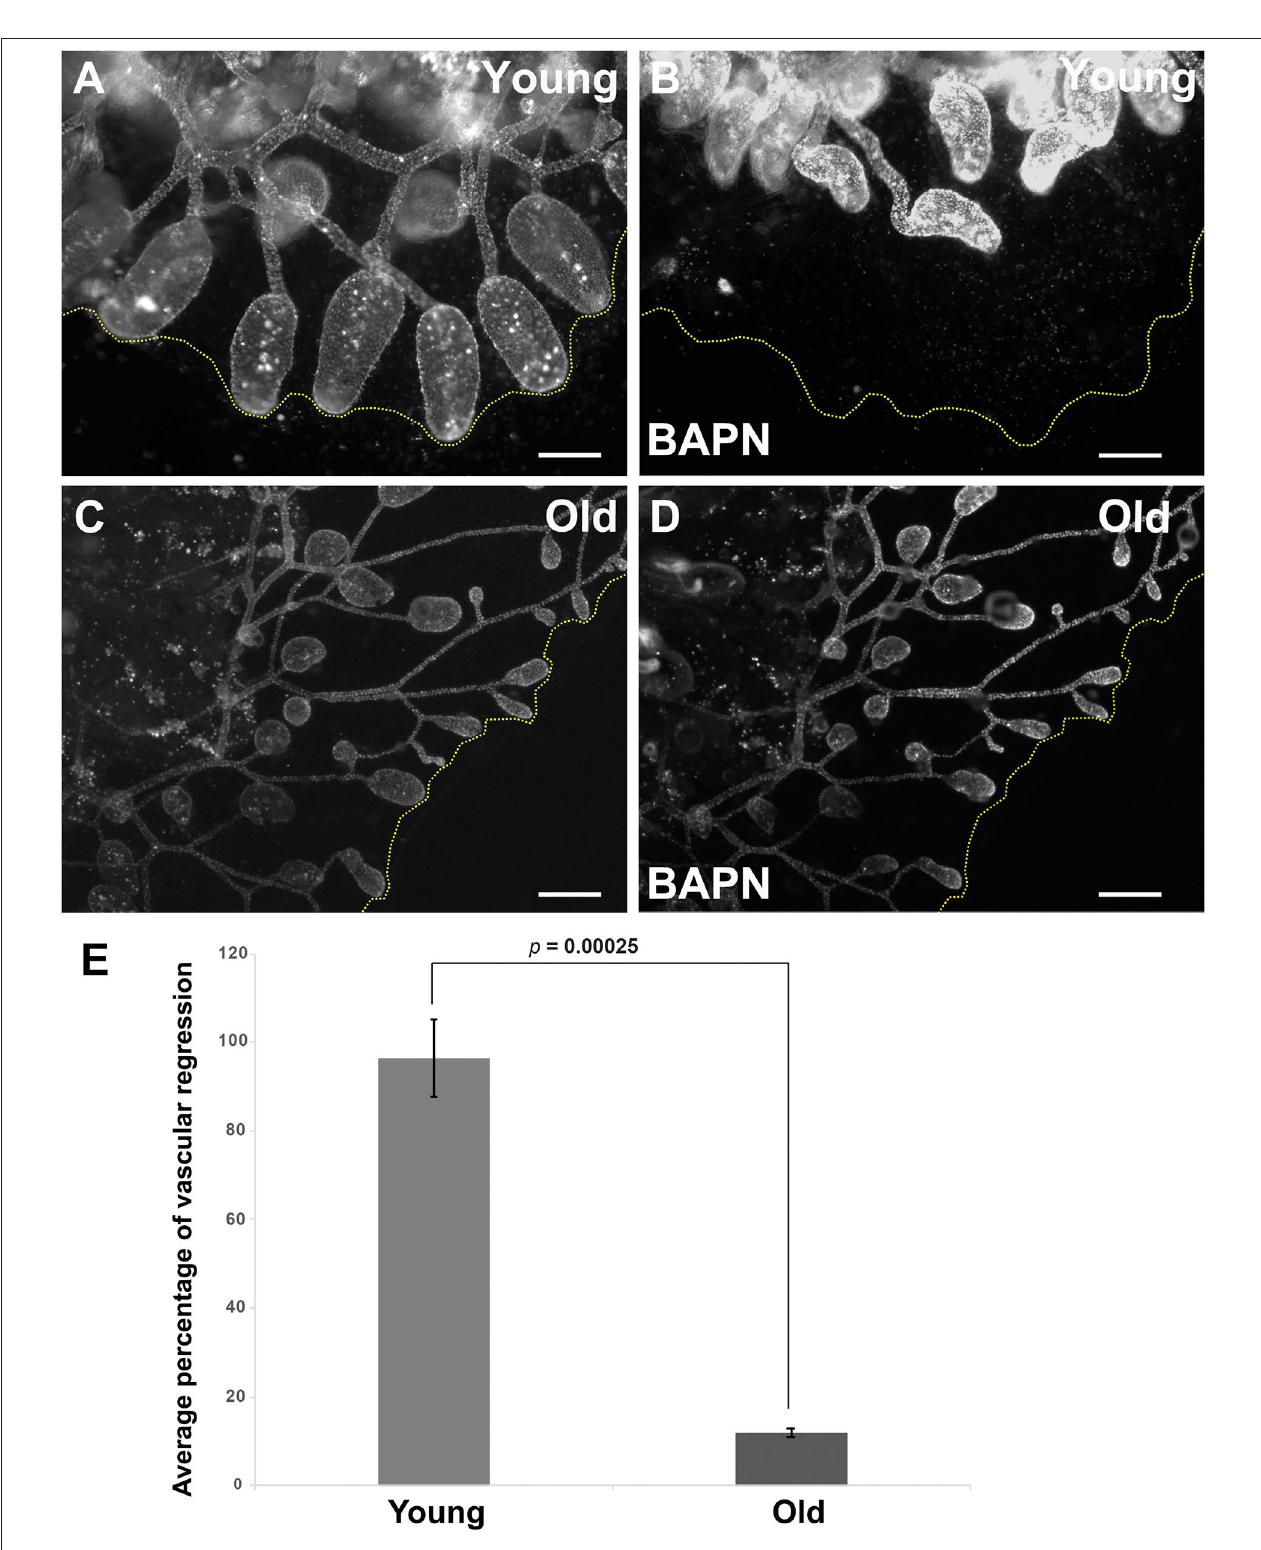
FIGURE 6 | Inducible vascular regression declines with age. (A,B) Representative fluorescent micrographs of the vascular bed labeled with BSA-Alexa Fluor 594 of a young colony before (A) and after BAPN treatment (B) . (C,D) Representative fluorescent micrographs of the vascular bed labeled with BSA-Alexa Fluor 594 of an old colony before (C) and after BAPN treatment (D) . (E) Average percentage changes of vascular bed perimeter were assessed 16h following BAPN exposure of young and old Botryllus colonies. Statistical analysis was performed using the Student’s t -test. Scale bars: 1mm.